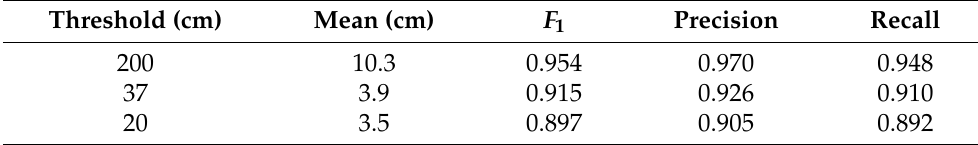
Figure 12. Precision and recall on test data set for different thresholds. Dotted lines with black text represent the 25% quantile, and dashed lines with white text represent the median, if not at 1.0. Table 3. Influence of the threshold on mean spatial error, F 1 , precision, and